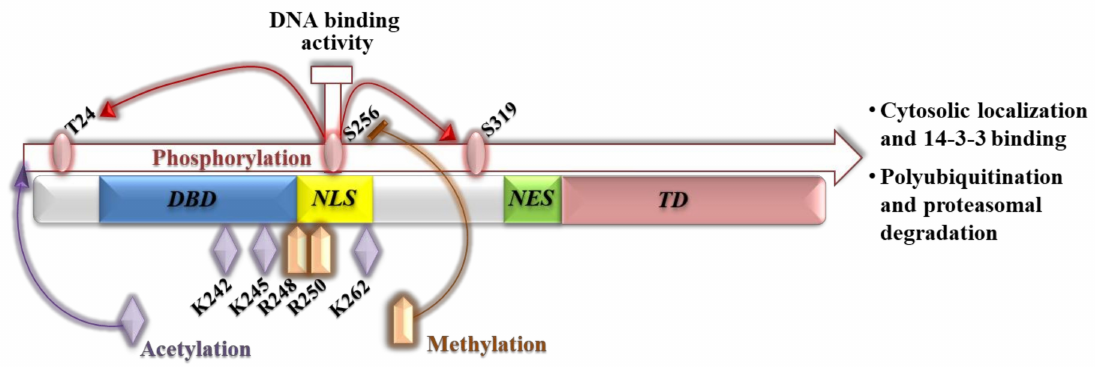
Figure 2. Scheme of human FoxO1 structure reporting the forkhead DNA-binding domain (DBD), the nuclear localization sequence (NLS), the nuclear export sequence (NES), and the C -terminal transactivation domain (TD). The main post-translational modifications of FoxO1 and their cross-talk are